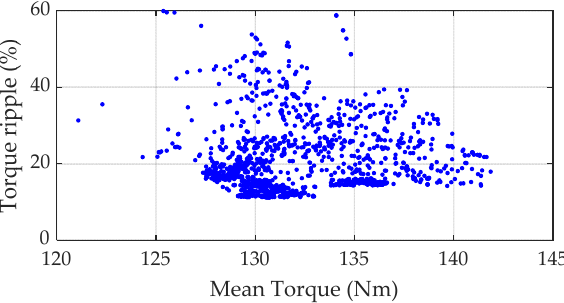
Figure 9. Designs obtained from the optimization process. The current was fixed to ~20 A/mm 2 and the current angle was defined in the optimization algorithm for MTPA.